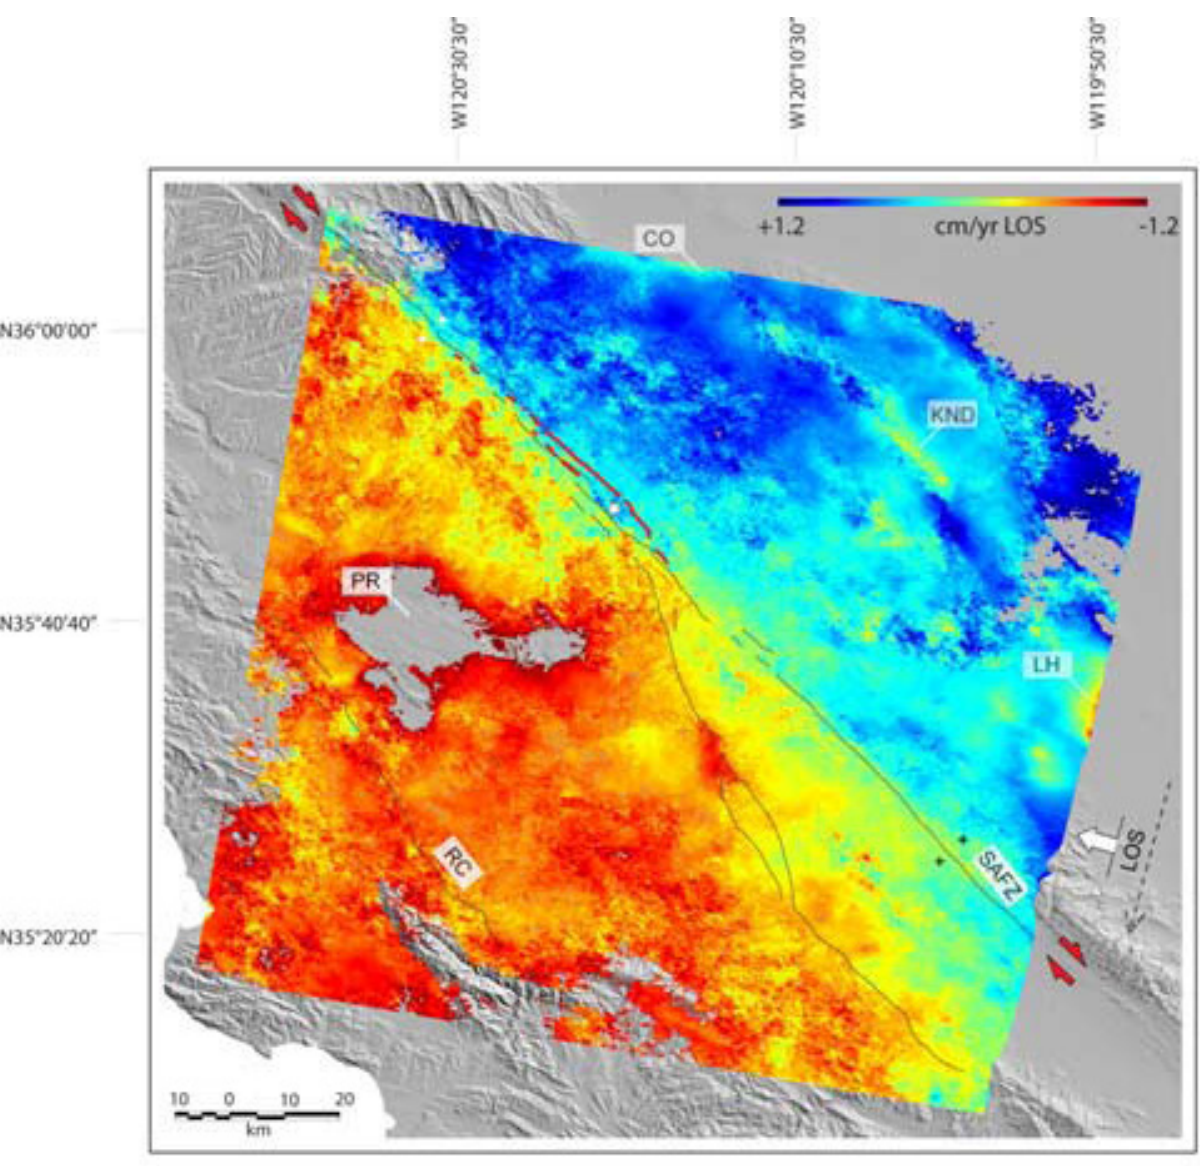
Figure 8. Pre-seismic strain buildup on the San Andreas Fault Zone at Parkfield. The map is composed by averaging 20 unwrapped ERS-1/2 interferograms in a stack. Each 20 × 20 m pixel is then a measure of the average in the line of sight direction velocity in the period 1992–2004 prior to the earthquake. The scale-bar values represent centimeters parallel to the fault